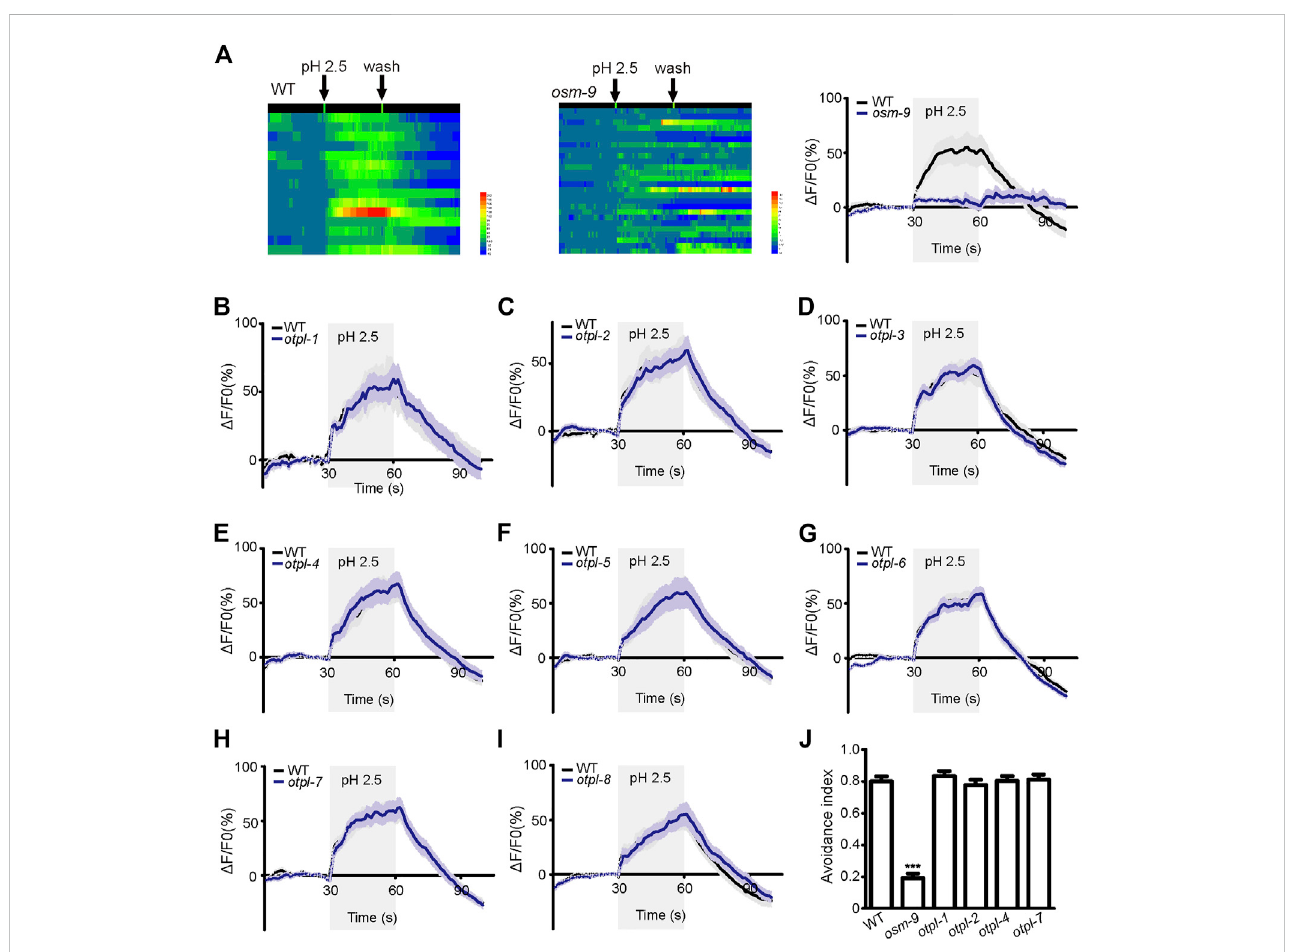
FIGURE 3 Otopetrin single gene mutations do not affect calcium responses of ASH neurons to acid stimulation and acid avoidance behavior in nematodes (A) ASH neuronswereabletoinducecalciumresponsestoacidstimulation, osm-9 mutantwasusedasanegativecontrol. (B – I) CalciumresponsesofASHneuronsto acid solution stimulation in all eight otopetrin single mutants, which were not signi fi cantly different from WT. (J) The mutant of four ASH neuron-expressing otopetrin genes did not affect acid avoidance behavior of nematodes. The number tested of each strain were 160 (WT), 173 ( osm-9 ), 150 ( otpl-1 ), 152 ( otpl-2 ), 162 ( otpl-4 ), and 142 ( otpl-7 ). One-way ANOVA, Dunnett ’ s test, *** p <